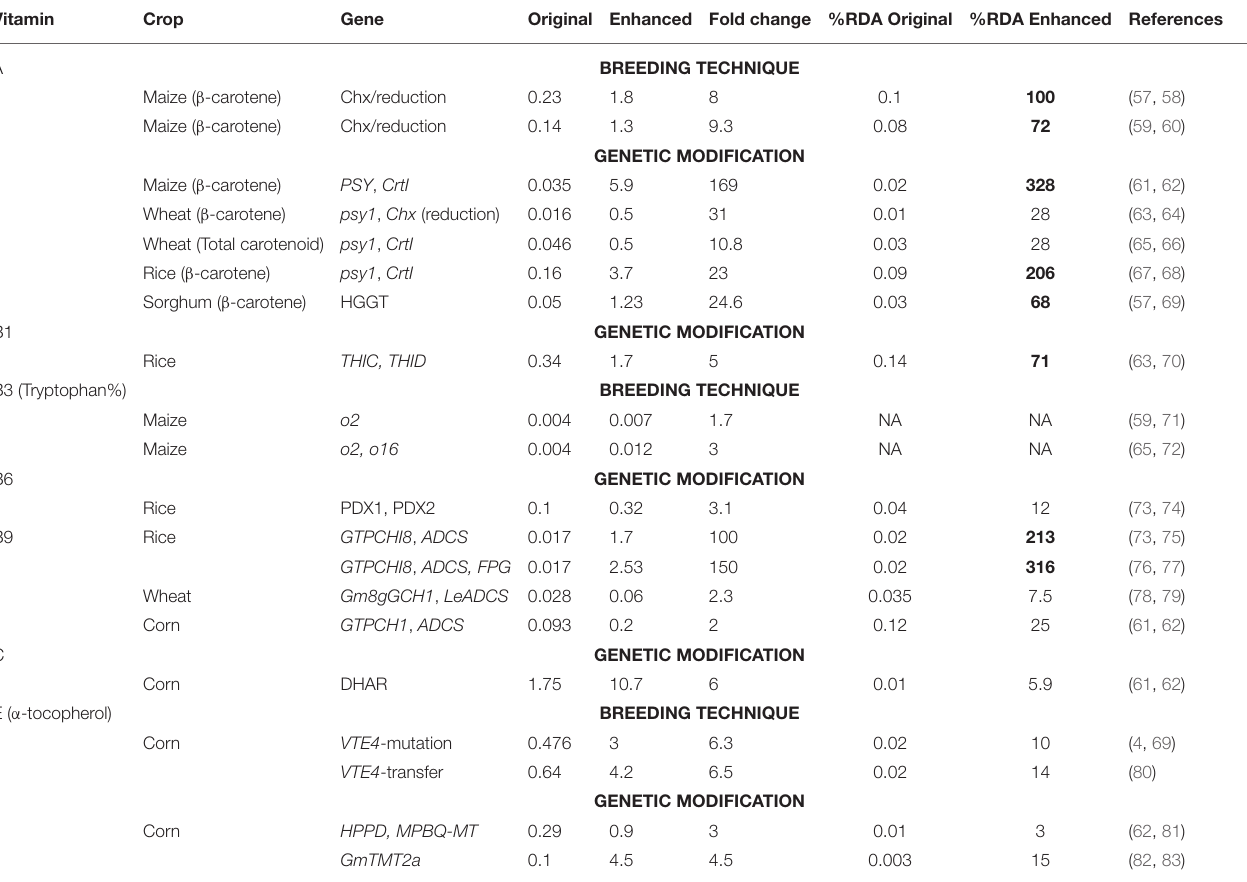
TABLE 5 | Biofortification of cereals to increase their vitamin content (mg/100g). Vitamin